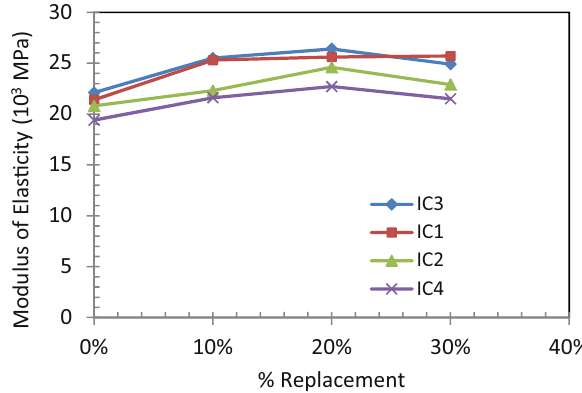
Fig. 8 Effect of percent replacement on modulus of elasticity of control and internally cured samples with w/c ratio of 0.4 under similar curing